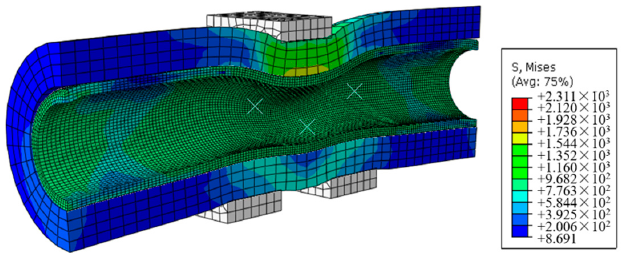
Figure 12. Equivalent stress distribution of cement-sheath with wall thickness of 50.8 mm.